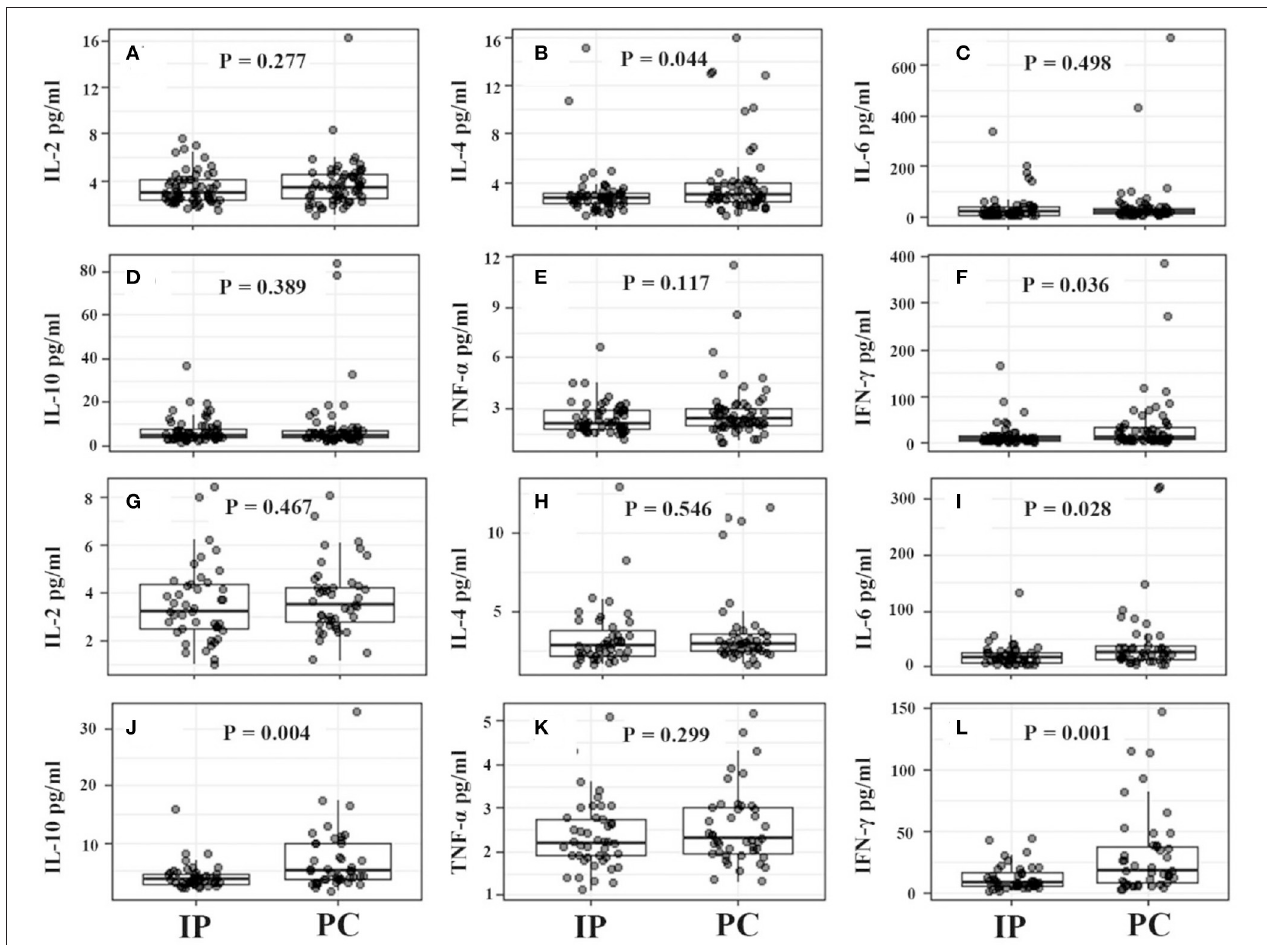
FIGURE 5 | Serum cytokine levels between IP and PC children ≤ 5 years (A–F) and > 5 years (G–L) after PSA. IFN, interferon; IP, interstitial pneumonia; PC, pulmonary consolidation; PSA, propensity score analysis; TNF, tumor necrosis